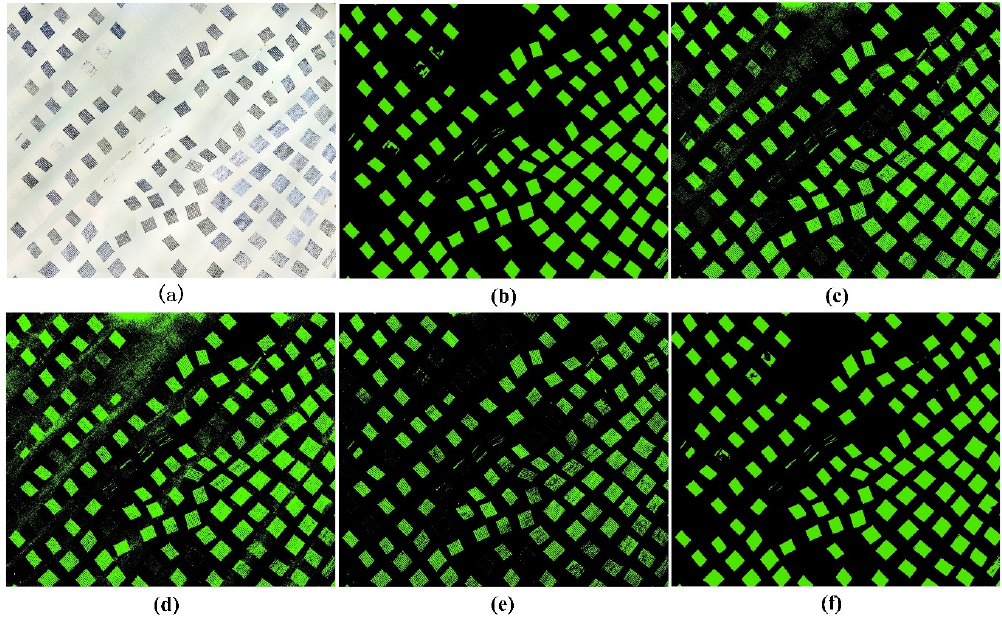
Figure 9. The result of MLC (Maximum likelihood classification), SVM (Support vector machine), NN (Neural network classification), and FCN (Fully convolutional neural network). ( a ) Remote sensing image; ( b ) The ground truth map; ( c ) The result of MLC; ( d ) The result of SVM; ( e ) The result of NN; ( f ) The result of FCN.